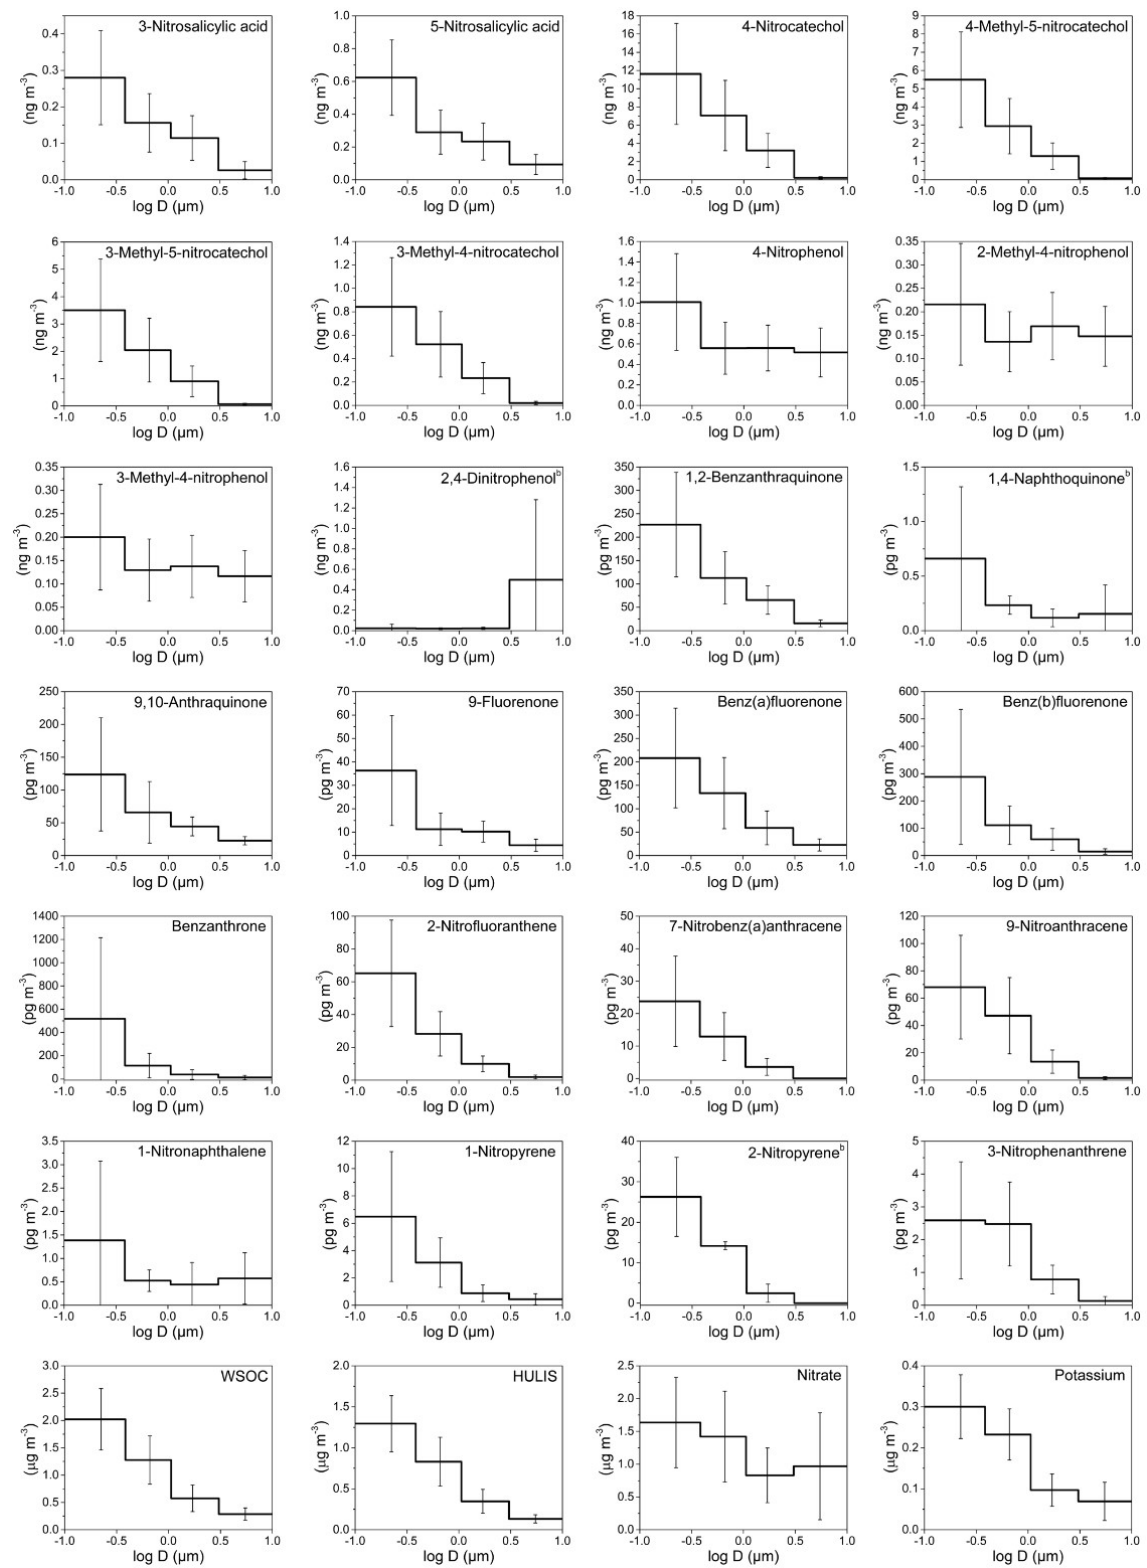
Figure 2. Mass size distributions (MSDs) of PM-bound NMAHs, NPAHs, OPAHs, WSOC, HULIS, and ions in Thessaloniki (Greece). The error bars represent standard deviations. b Compound MSD calculated from three (out of five) sample sets (detected and quantified in three sample sets